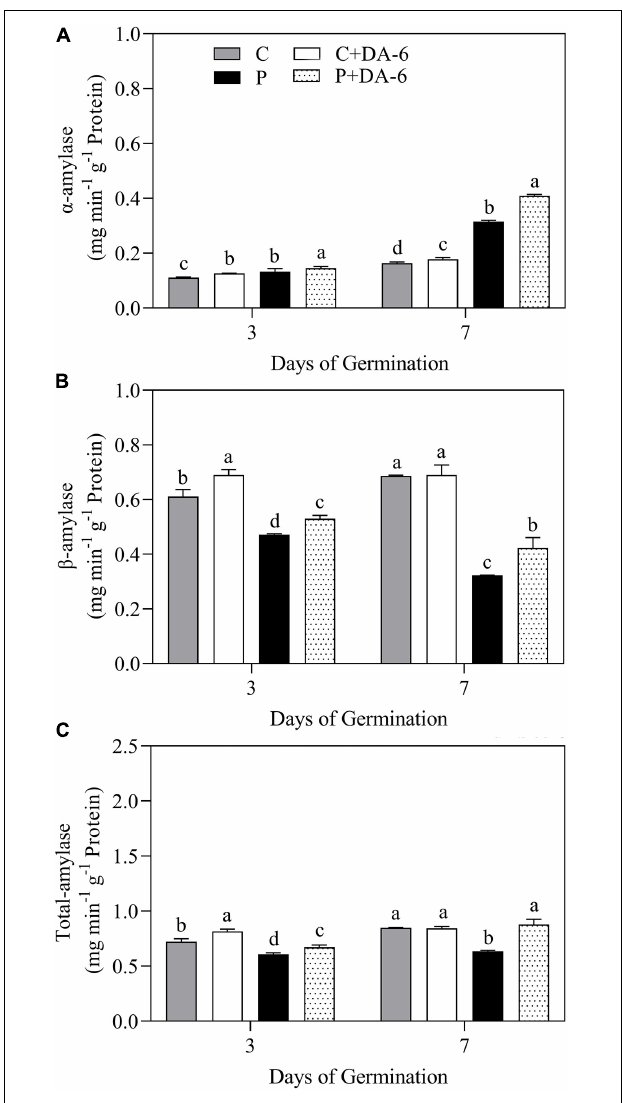
FIGURE 4 | Effect of seed priming with distilled water or DA-6 (2 mM) on (A) α -amylase activity, (B) β -amylase activity, and (C) total amylase activity after 3 and 7 day of germination in white clover under well-watered condition and drought stress. Different letters above different treatments represent significant differences at a specific time point under well-watered condition or drought stress ( p ≤ 0.05). Vertical bars show the ± SE of mean ( n =